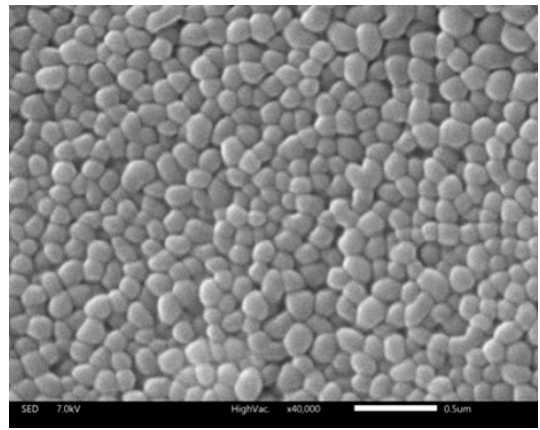
Figure 2. SEM image of DS-lipo. Notes: Magnification: ×50,000. Scale bar = 0.5 μ m.